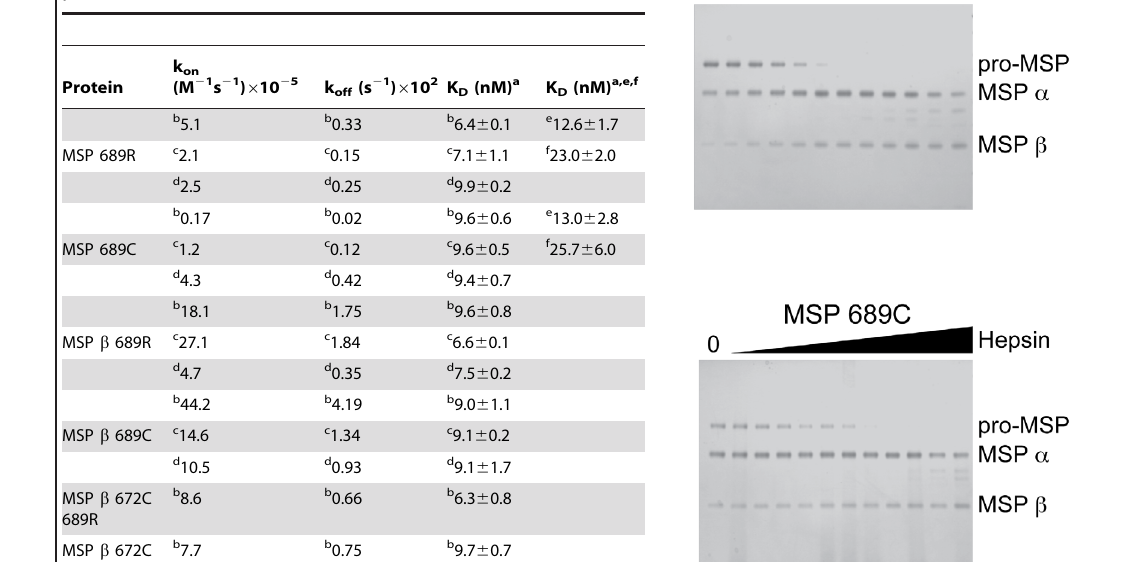
Table 1. Binding kinetics and affinities of MSP 689R and 689C proteins to RON.